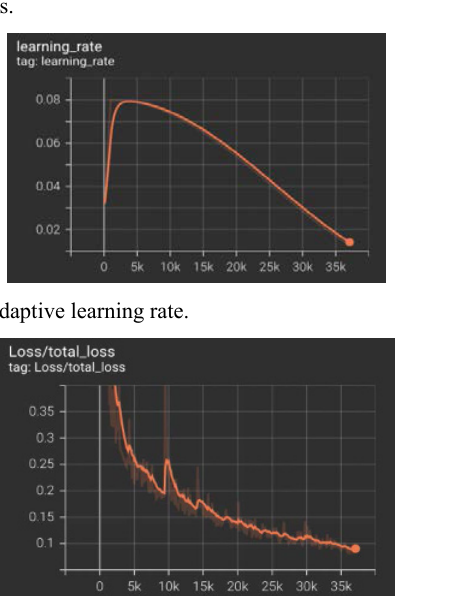
Fig. 6. The total loss rate of the SSD network